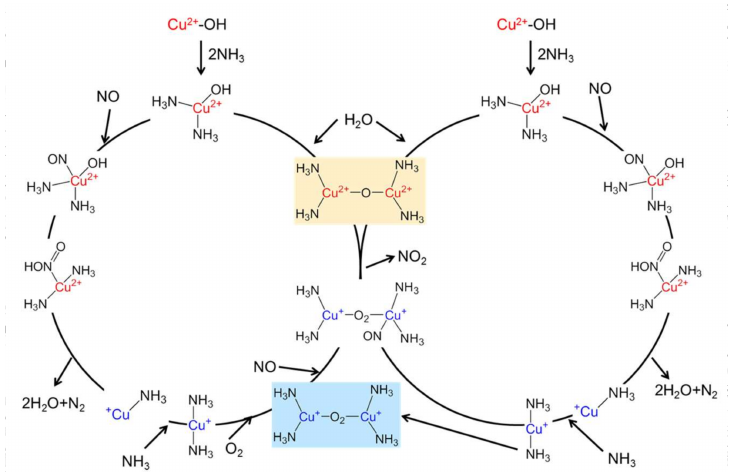
Figure 13. Complete redox cycling mechanism for low-temperature standard NH 3 -SCR derived from DFT calculations that involves two Cu(I) centers in the initiation of the oxidation half-cycle. Adapted with permission from J. Am. Chem. Soc. , 2017 , 139 , 4935–4942. Copyright 2017, American Chemical